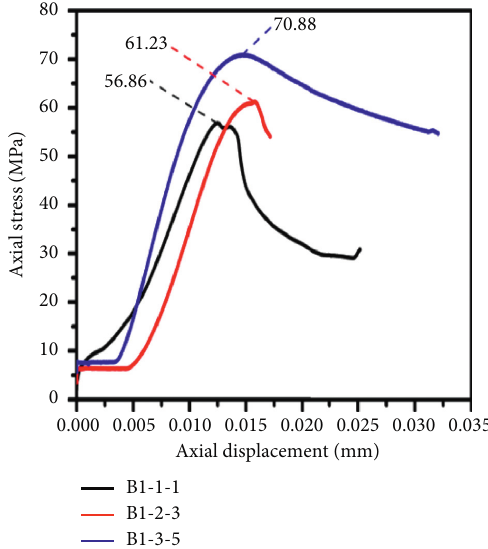
Figure 13: Axial displacement-axial stress curve of group B1.